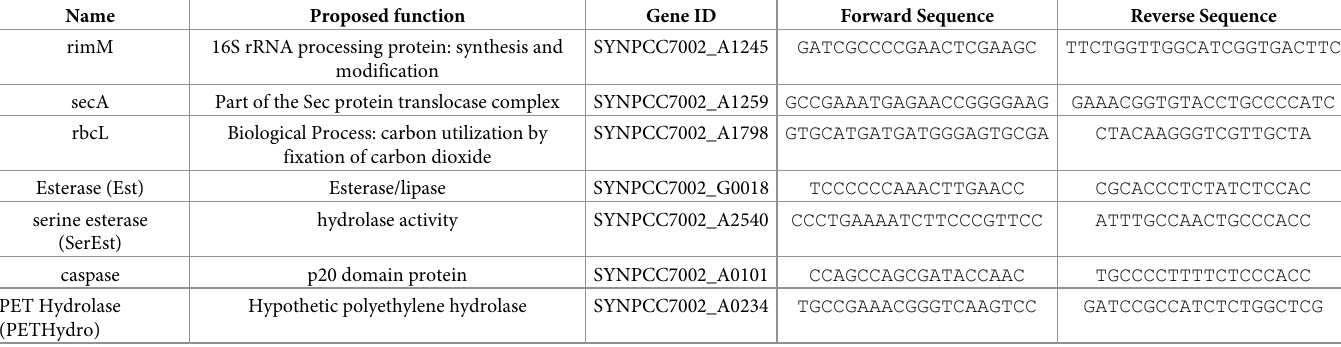
Table 1. Reference genes [22] and potential hydroloases and esterases were identified from the literature. [23], [24], [25] Evaluation of a metacapase (p-20 domain protein) [26] was also included within this